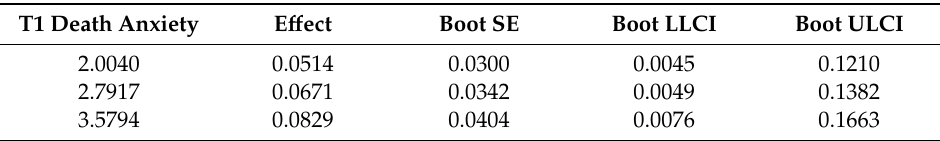
Table 4. Conditional indirect e ff ects of T1 Financial Goals on T3 Retirement Savings Adequacy through T2 Financial Behavior as a function of the T1 Death Anxiety